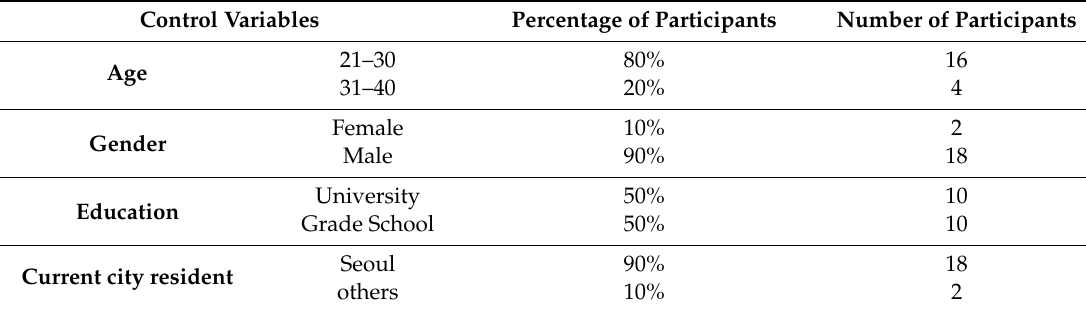
Table 4. Descriptive statistics of control variables.